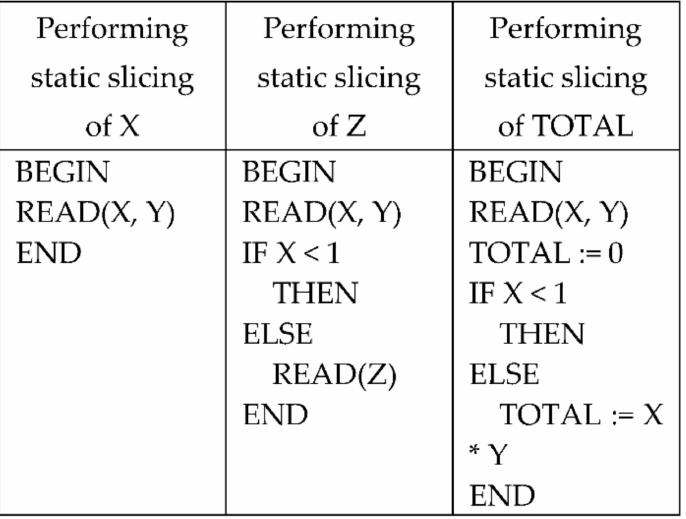
Figure 3. Result of static slicing of X, Z, and TOTAL.